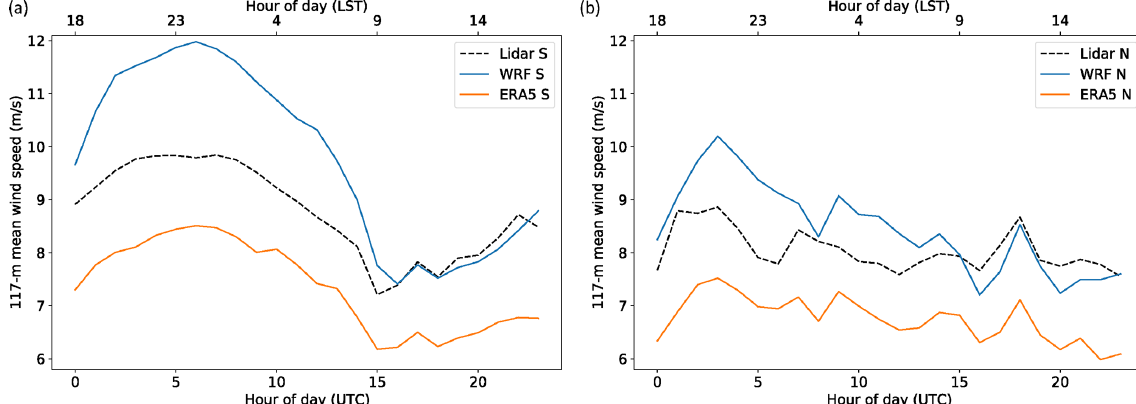
Figure 11. Average diurnal cycle of the 117m wind speed from lidar, WRF, and ERA-5 at the SGP C1 site for (a) southerly (112–196 ◦ ) and (b) northerly (315–45 ◦ ) wind flow.